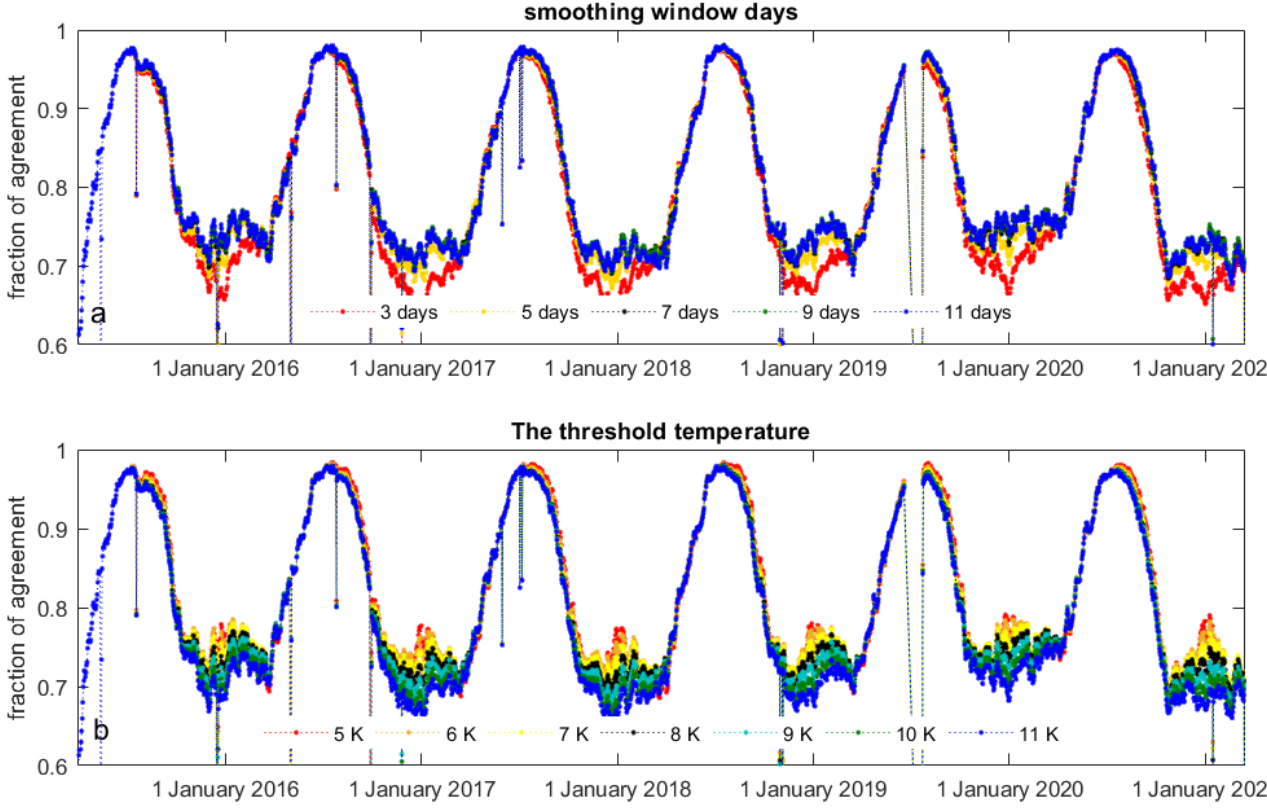
Figure 11. The time-series of the fraction of agreement between the new method and the FT state inferred from ERA-land-assessment data in the northern hemisphere regarding ( a ) β , the window length for the variance; and ( b ) γ , the threshold temperature difference.